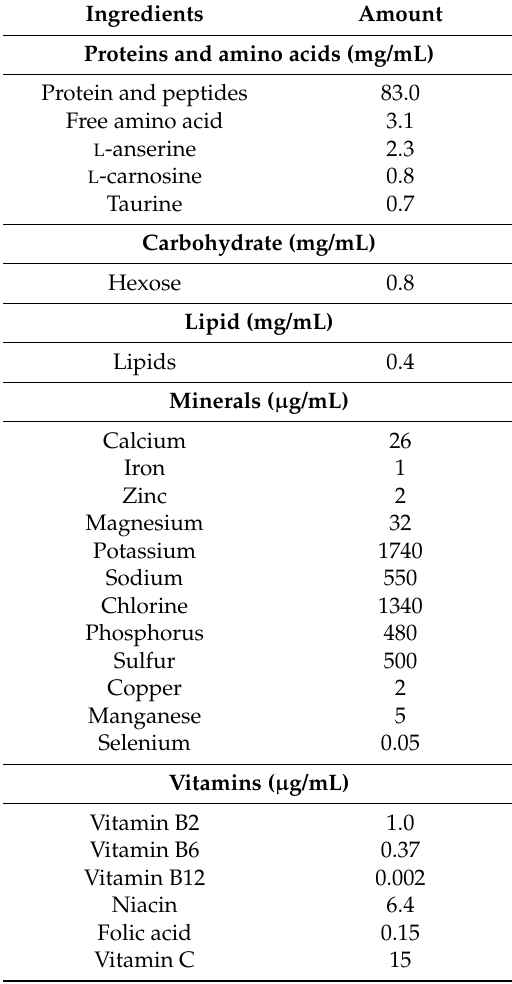
Table 1. Nutritional Content of BRAND’S Essence of Chicken